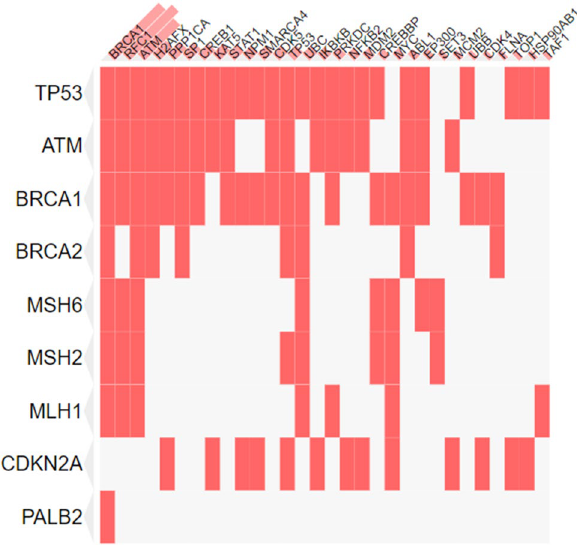
Figure 1. Gene enrichment result from the Enrichr server. From the curated protein–protein interactions, BRCA1, ATM and TP53 is more enriched in connectivity on a clustegram